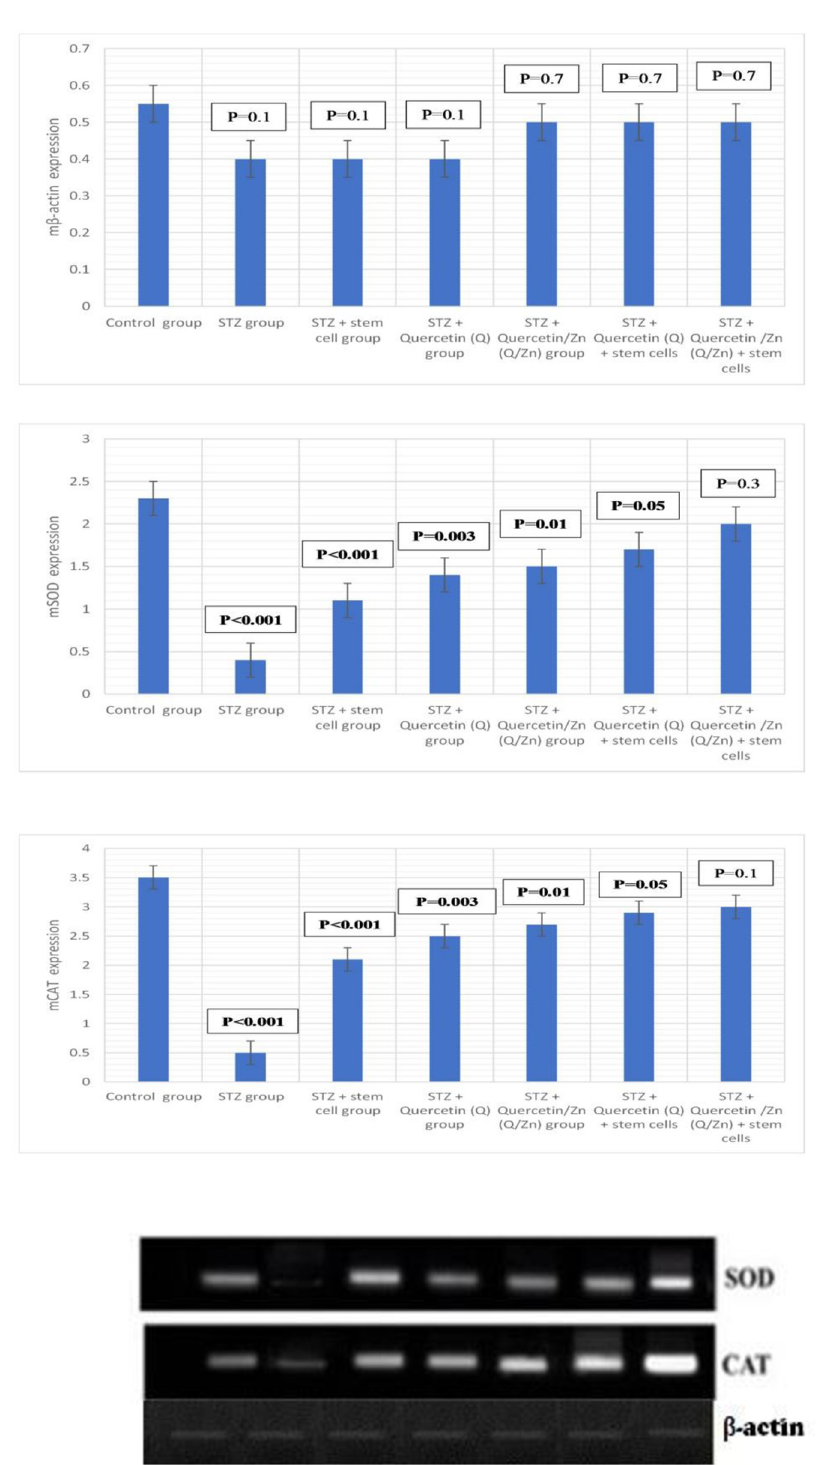
Fig 16. Gene expression of mCAT, mSOD and m β -actin in lung tissues (mean ± S.E) (n = 8). Autoradiograms for RT-PCR products corresponding to the different groups in the experiment. Whereas, Represents the expression of SOD, CAT and β -actin. Where, P-value � 0.05 was considered significant. P-value < 0.001 was considered highly significant. P-value > 0.05 was considered non-significant.